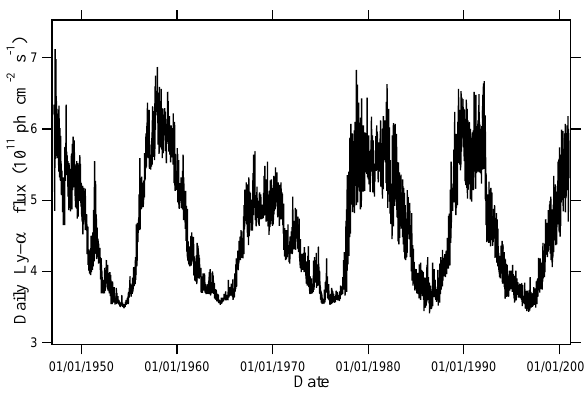
Fig. 5. Daily Lyman- α solar irradiance from 1947 to 2000.